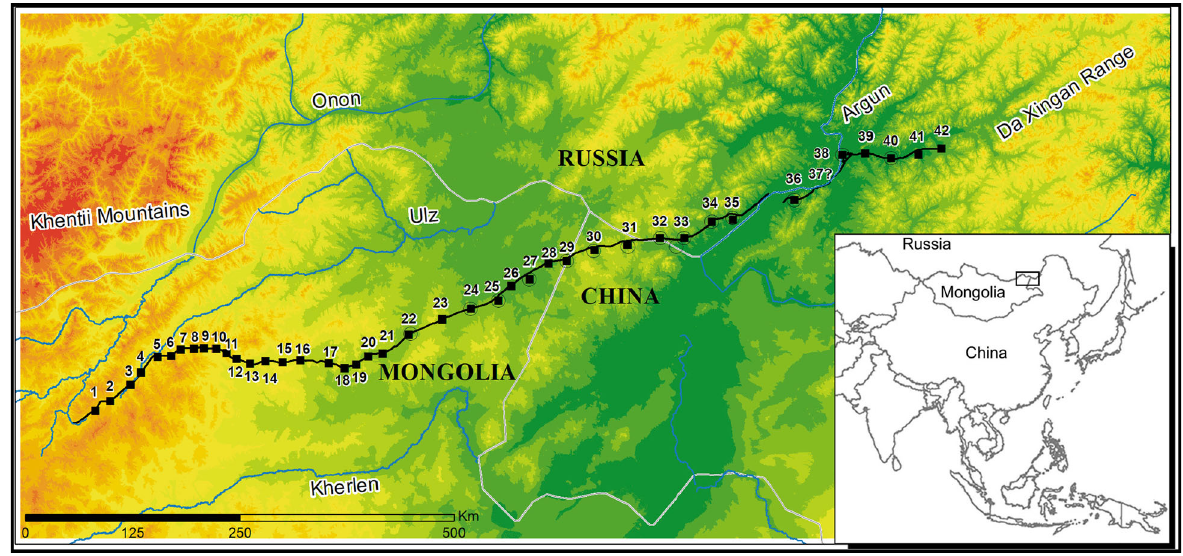
Fig. 1 A Map of the wall-system line. The squares indicate the locations of clusters of auxiliary structures and are sequentially numbered from west to east. The small map indicate the location of the wall-system in East